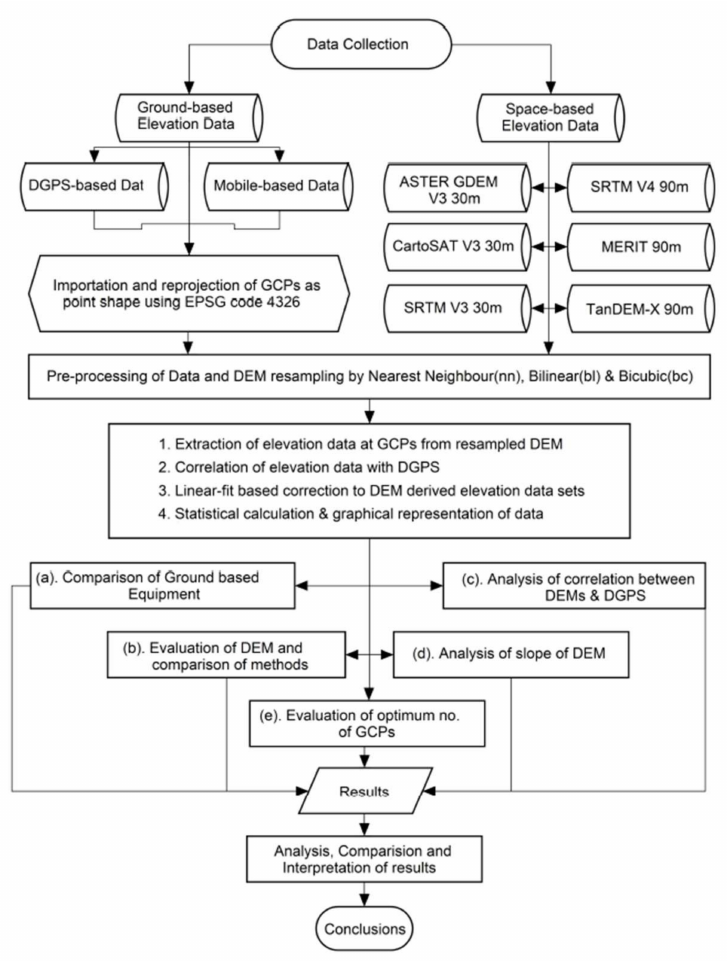
Figure 2. The flowchart summarizes the methodology, techniques, and comparative analysis carried out in this